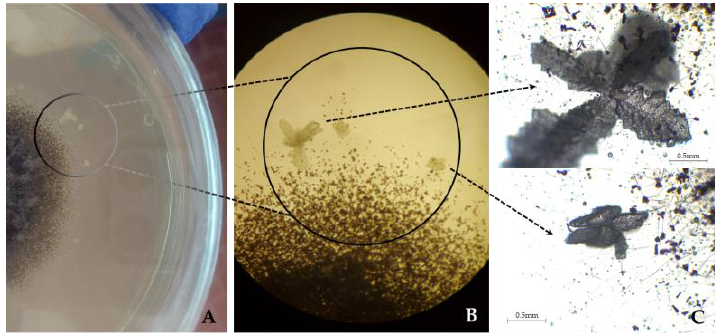
Figure 4. The appearance of the Aspergillus penicillioides colony on HM 10% medium, after maturation (gray mycelium), displaying precipitated crystals. ( A ) Direct visualization of the culture plate. ( B ) Observed under the light microscope (100×). ( C ) Observed under the light microscope (400×). Aspergillus penicillioides , an obligate halophile commonly found in hypersaline envi-